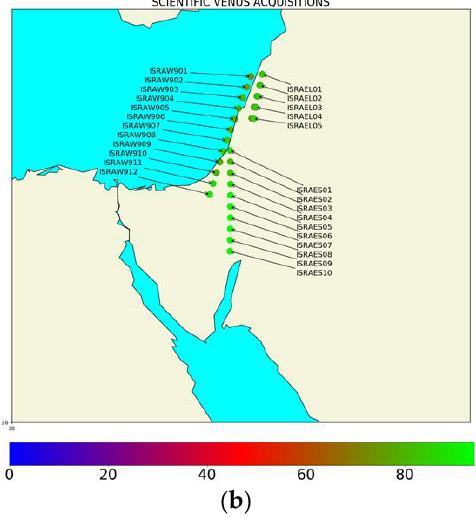
Figure 54. ( a ) Percentage of valid Level-1 products for North America; ( b ) percentage of valid Level-1 products for Israel.